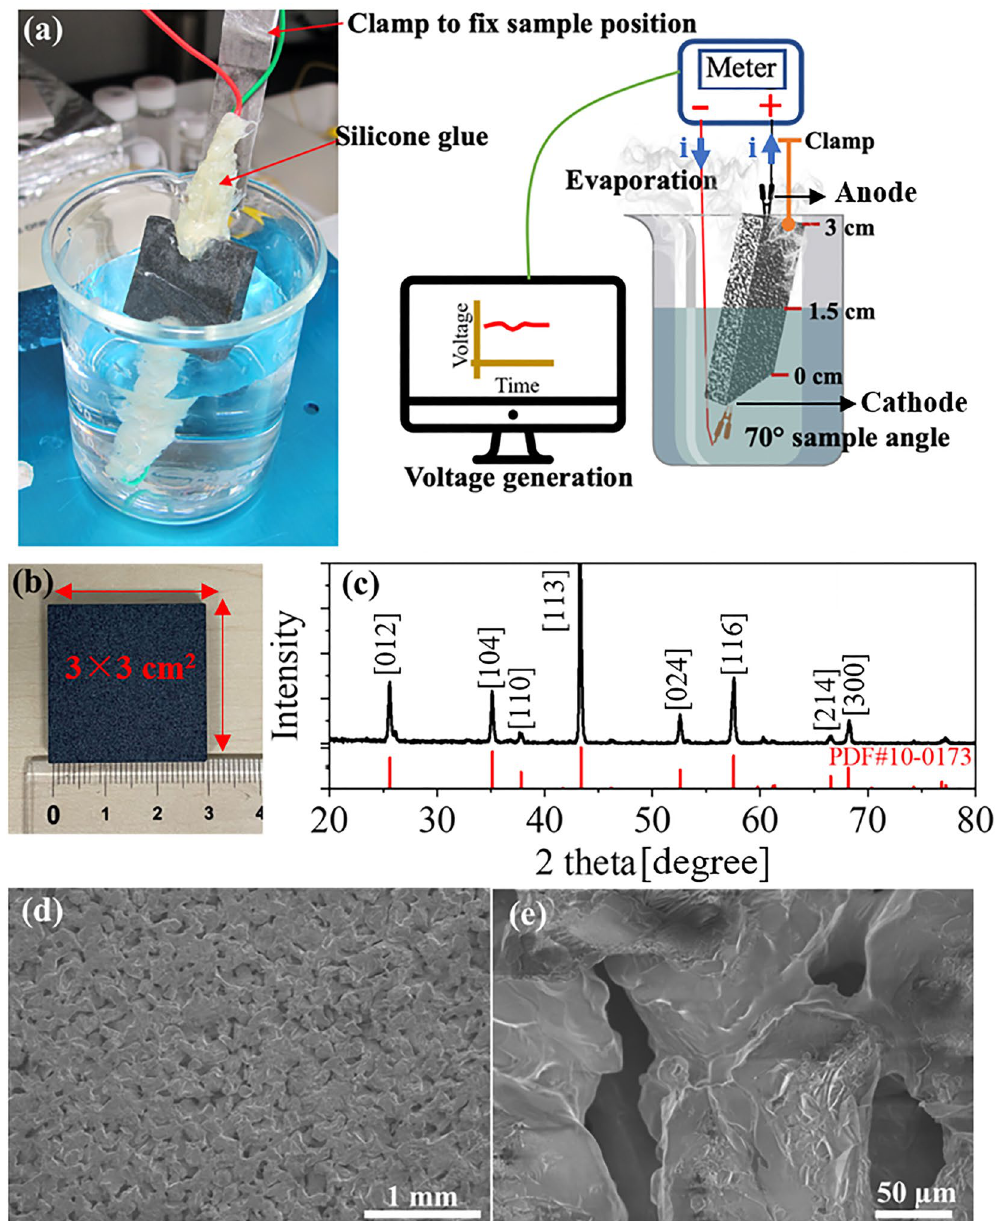
Figure 1. ( a ) Schematic diagram of the experimental setup and a photograph of the device. ( b ) Photograph of the porous alumina block. ( c ) XRD pattern (black curve) of the alumina and a pattern from the PDF card (10- 0173) (red). ( d ) SEM image of alumina. ( e ) Magnified view of ( d